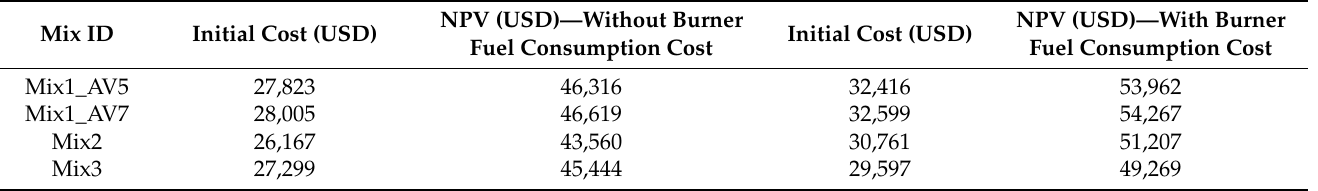
Table 3. NPVs for all mixtures.